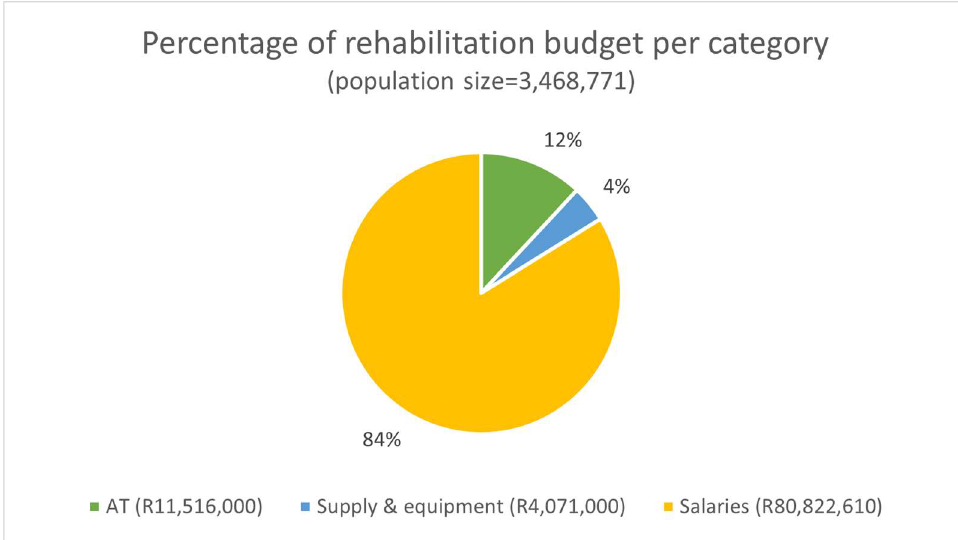
Figure 1. Budget summary of one rural province . Legend: AT—assistive technology.